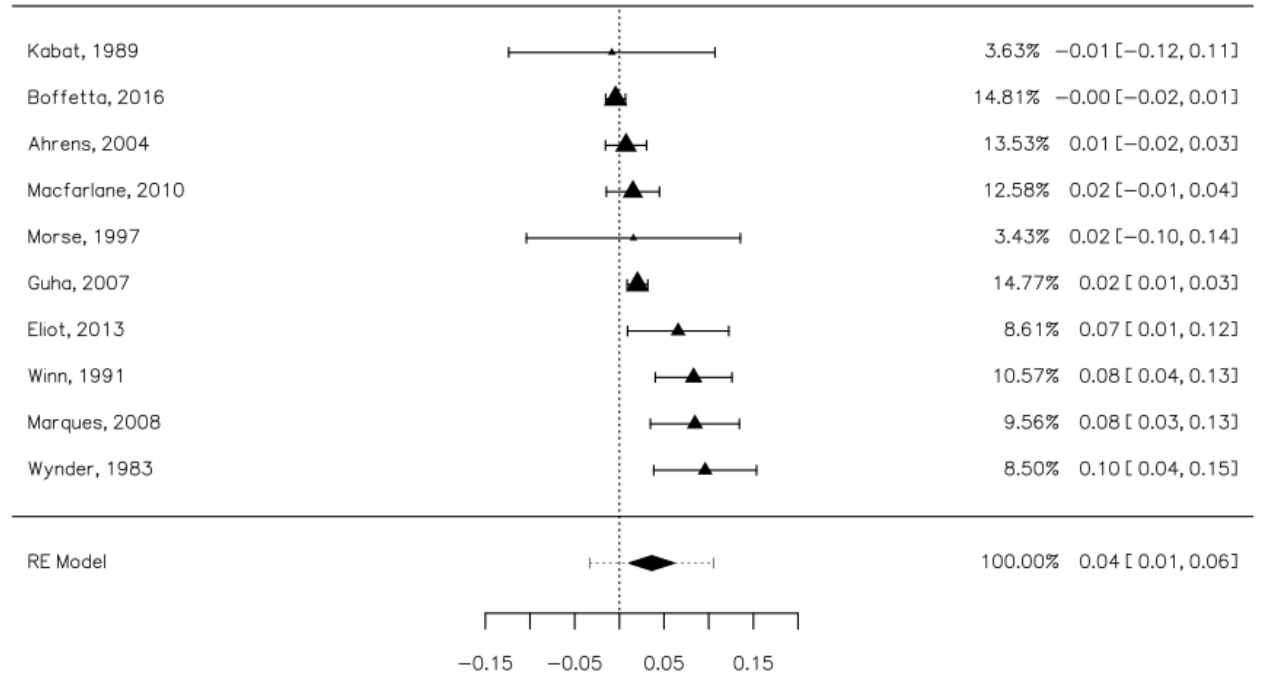
Figure 3. Forrest plot. The risk of upper aerodigestive tract cancers associated with frequent mouthwash